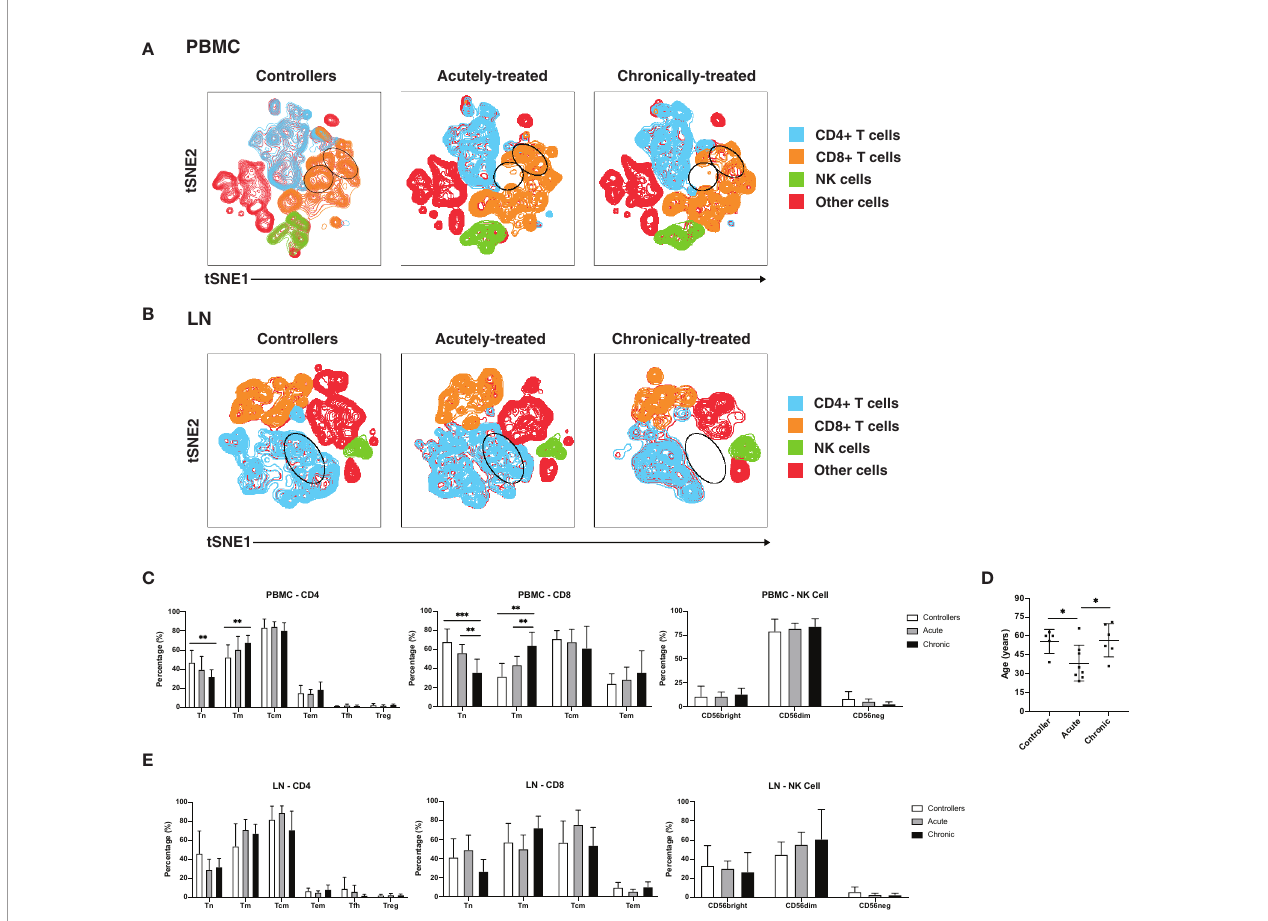
FIGURE 1 | Characterization of T and NK cells from PBMCs and LNs of HIV controllers and non-controller HIV+ individuals treated during acute or chronic infection. (A, B) t-distributed stochastic neighbor embedding (tSNE) plots for T and NK cells from PBMCs (A) and LNs (B) of HIV controllers (left), acutely-treated (middle), and chronically-treated (right) HIV+ individuals. The main subsets analyzed are each colored as indicated. Some subsets of T cells were preferentially detected in the controllers (regions circled in black). (C) Blood naïve T cells are more frequent in controllers than HIV+ ART-suppressed individuals. Shown are frequencies of canonical subsets in PBMCs from the indicated groups of HIV+ individuals among CD4+ T cells (live, singlet, CD19-CD14-CD33-CD3+CD8-, left), CD8+ T cells (live, singlet, CD19- CD14-CD33-CD3+CD8+, middle) and NK cells (CD19-CD14-CD33-CD3-CD4-CD7+, right). Subsets of CD4+ and CD8+ T cells were de fi ned as follows: naïve T cells (Tn): CD45RO-CD45RA+; memory T cells (Tm): CD45RO+CD45RA-; central memory T cells (Tcm): CD45RO+CD45RA-CCR7+CD27+; and effector memory T cells (Tem): CD45RO+CD45RA-CCR7-CD27-. In addition, CD4+ T cells were further subsetted into T follicular helper cells (Tfh): CD45RO+CD45RA-CXCR5+PD1+; and regulatory T cells (Treg): CD45RO+CD45RA-CD25+CD127-. Subsets of NK cells were de fi ned based on CD56 bright , CD56 dim , and CD56- staining. (D) Age distribution of participants in each group. Controllers were not younger than HIV+ ART-suppressed individuals. (E) Frequencies of canonical T and NK cell subsets from LNs are similar between controllers and HIV+ ART-suppressed individuals. Frequencies of the indicated subsets of CD4+ T cells (left), CD8+ T cells (middle), and NK cells (right) in LNs from the indicated groups are shown. *p<0.05, **p<0.01, ***p<0.001 as assessed using the Student ’ s unpaired t